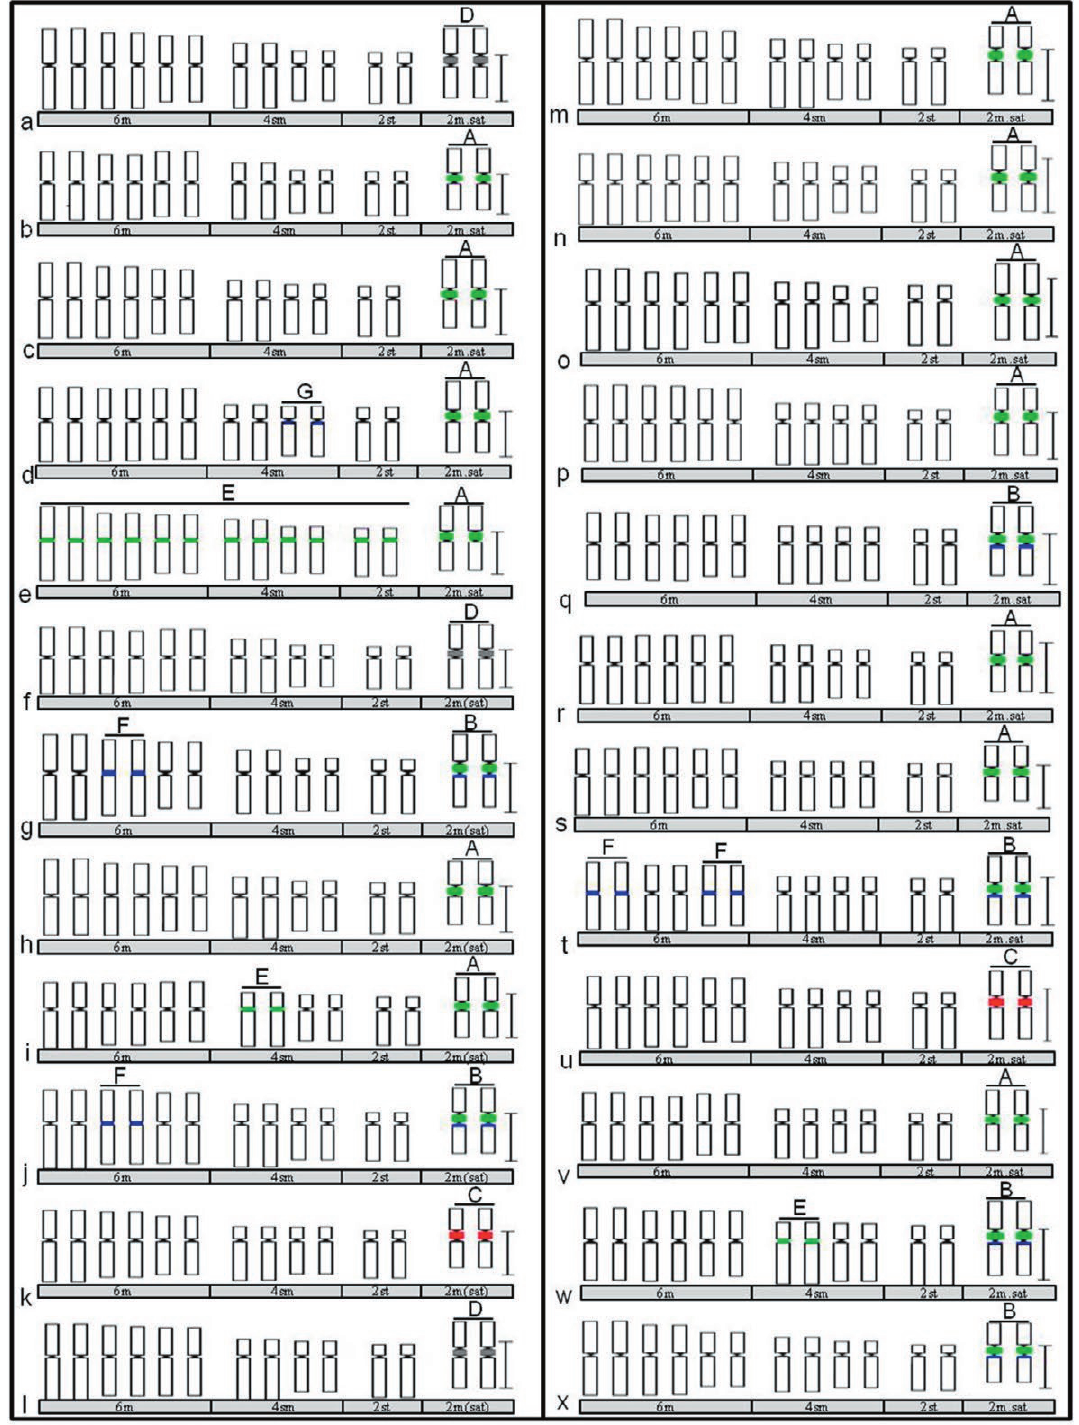
Figure 4. Fluorescent ideograms of Lens culinaris cultivars based on CMA/DAPI banding pattern: (a) DPL-15, (b) DPL-62, (c) IPL-81, (d) IPL-406, (e) IPL-316, (f) JL-1, (g) HUL-57, (h) KLS-210, (i) EC-70394, (j) EC-70403, (k) EC-70404, (l) EC-78452, (m) EC-78455, (n) EC-78461, (o) EC-78475, (p) EC-78498, (q) EC-78542-A, (r) EC–223188, (s) EC – 255491, (t) EC–267526, (u) EC-267569-A, (v) EC–267590, (w) EC–267877, (x) Barasat Micro type. CMA + , DAPI + , CMA + /DAPI + and CMA 0 bands are highlighted with green, blue, red and grey colors on the chromosomes, respectively and the types are indicated above the chromosome diagrams. Bars